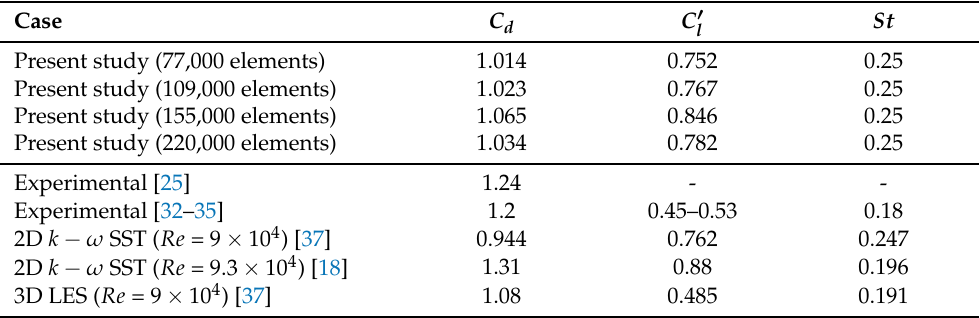
Table 1. Effect of mesh density on the characteristic dimensionless numbers averaged between 1 and 2 s of flow time in quasi-steady-state flow at Re = 4.2 × 10 4 , compared to the values from the experimental and numerical